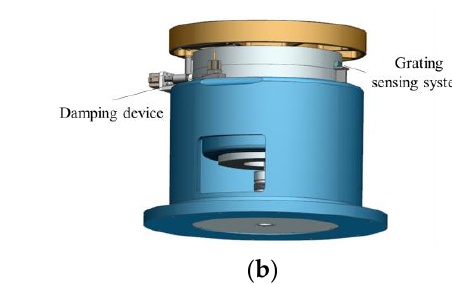
( b ) Figure 9. ( a ) Sensor measurement system model; ( b ) automatic centering assembly model. 2.2.3. MOI Measurement Mechanism